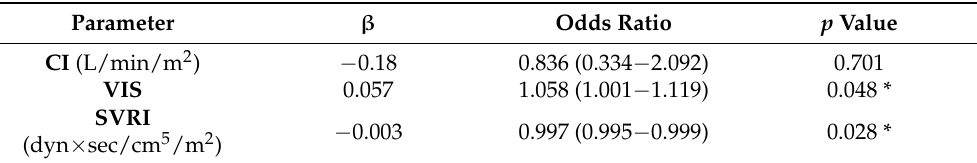
Table 3. Comparison of CI, SVRI, VIS, and ROC at six-hour intervals between survivors and non-survivors.